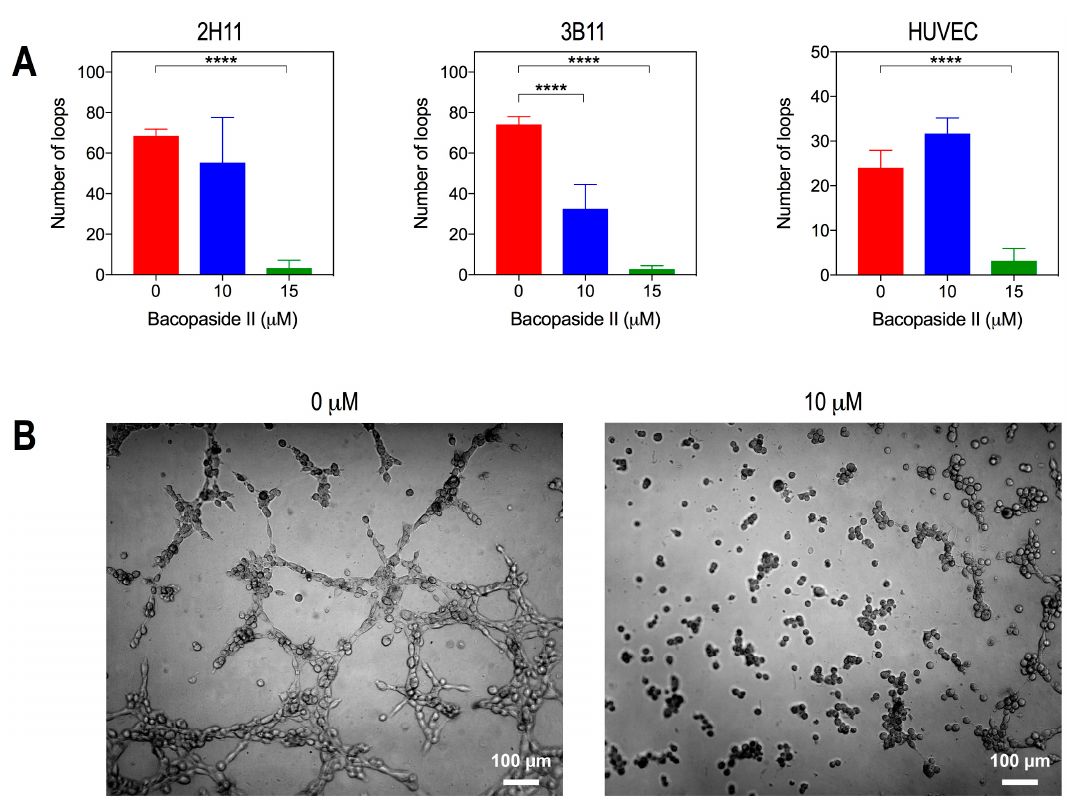
Figure 6. Endothelial cell tube formation was inhibited by bacopaside II. ( A ) 2H11, 3B11 and HUVEC were treated with 0, 10, or 15 μ M bacopaside II for 2–3 h (2H11 and 3B11) or 20 h (HUVEC) and the number of loops counted. Data are the mean ± SD of six replicates from two independent experiments. Asterisks represent p -values relative to the vehicle control (**** p < 0.0001). ( B ) Representative images of 3B11 on matrigel-coated plates treated with 0 and 10 μ M bacopaside II.